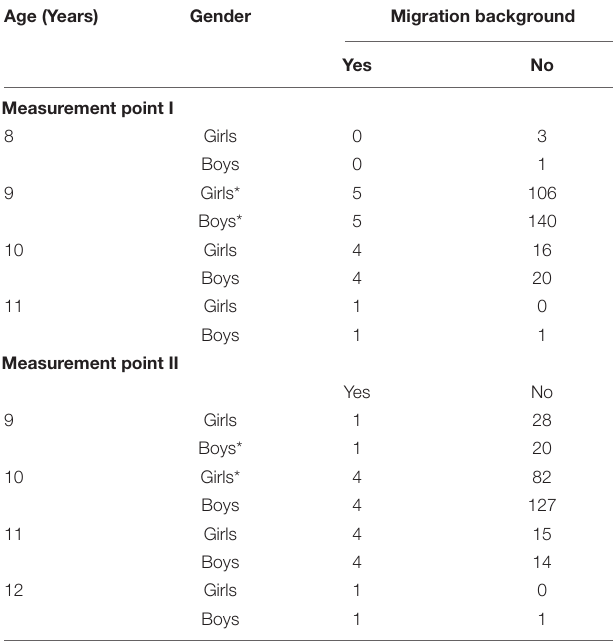
TABLE 1 | Distribution of sex X age X language background in T1 and